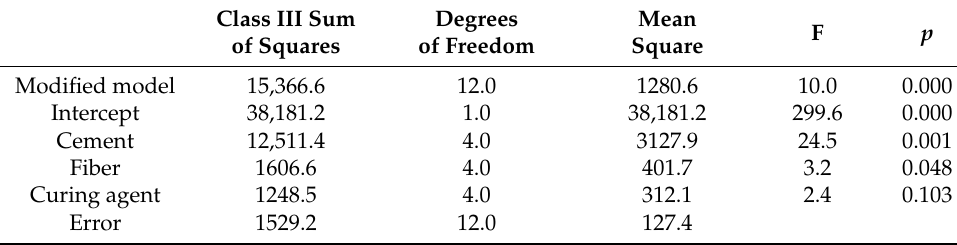
Table 7. Results of variance analysis of the compressive